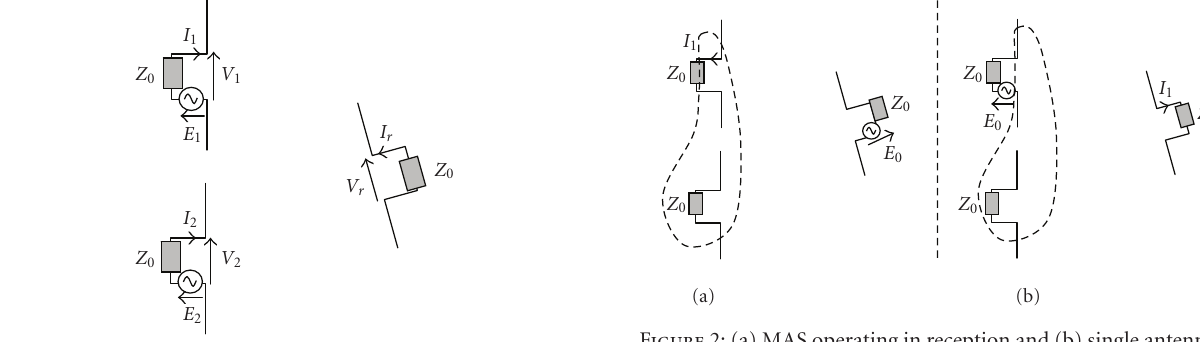
Figure 2: (a) MAS operating in reception and (b) single antenna in